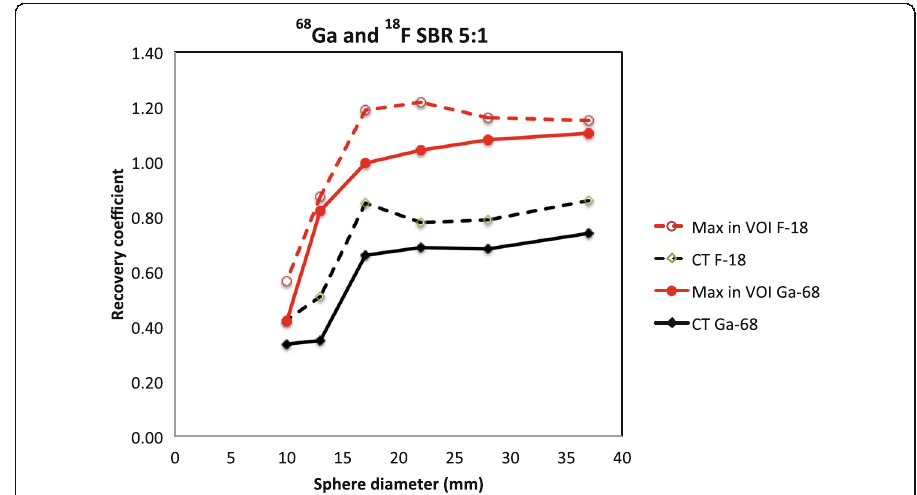
Fig. 4 Recovery curves for maximum value in VOI and mean value in CT-based ROI for 68 Ga and 18 F for SBR